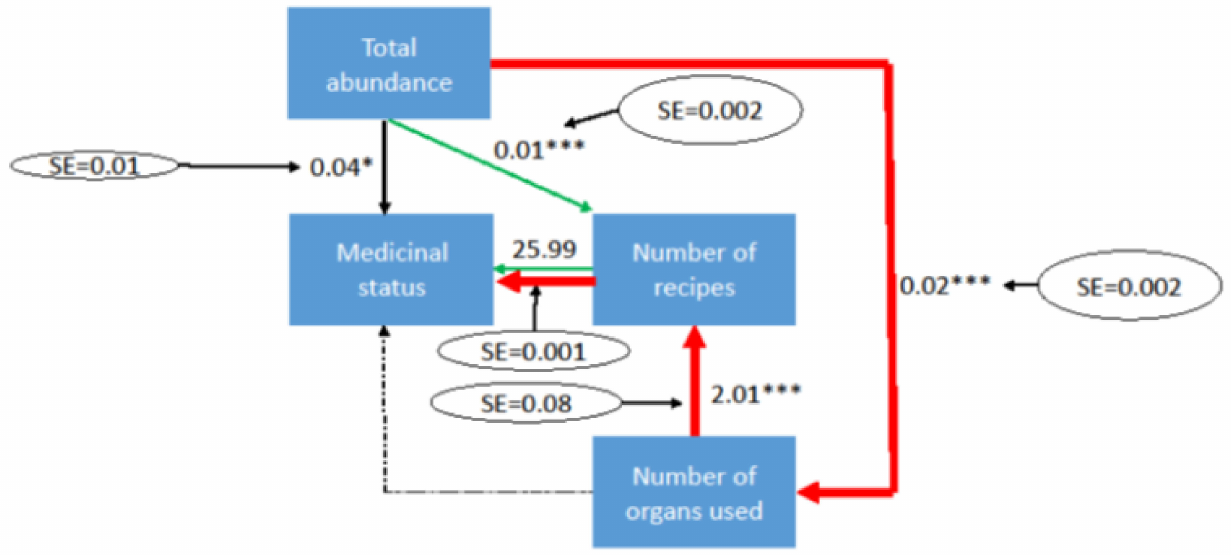
Figure 1. Meta-model illustrating the prediction of availability hypothesis. Different paths (arrows) of the relationships of total abundance with medicinal status are color-coded; black = direct path, green = shortest indirect path, and red = longest and most strong indirect path. The width of arrow is indicative of the strength of the relationships between two variables. Values on the arrows are path coefficients; SE, standard error. The number of stars indicates the level of statistical